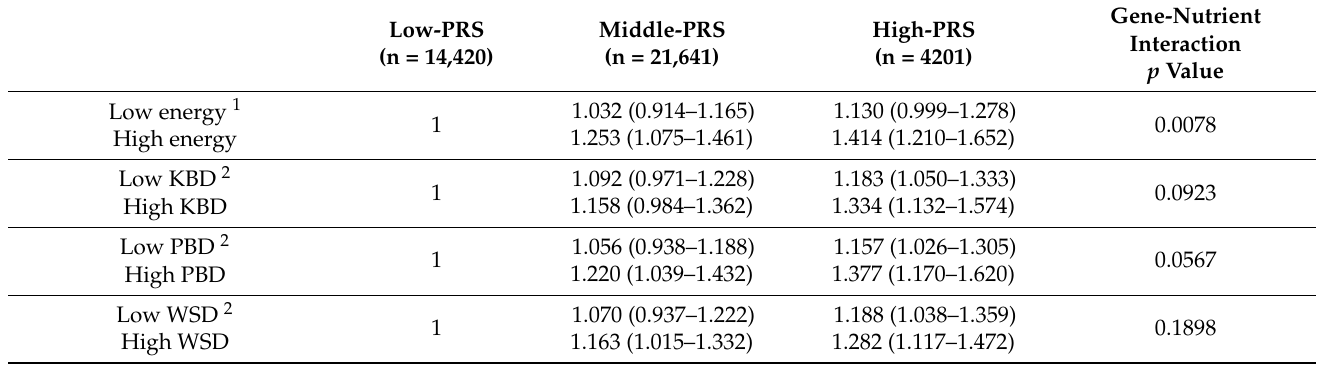
Table 6. Adjusted odds ratios for adult height risk by polygenetic risk scores (PRS) of the 4-SNP model for SNP-SNP interaction after covariate adjustments according to the patterns of